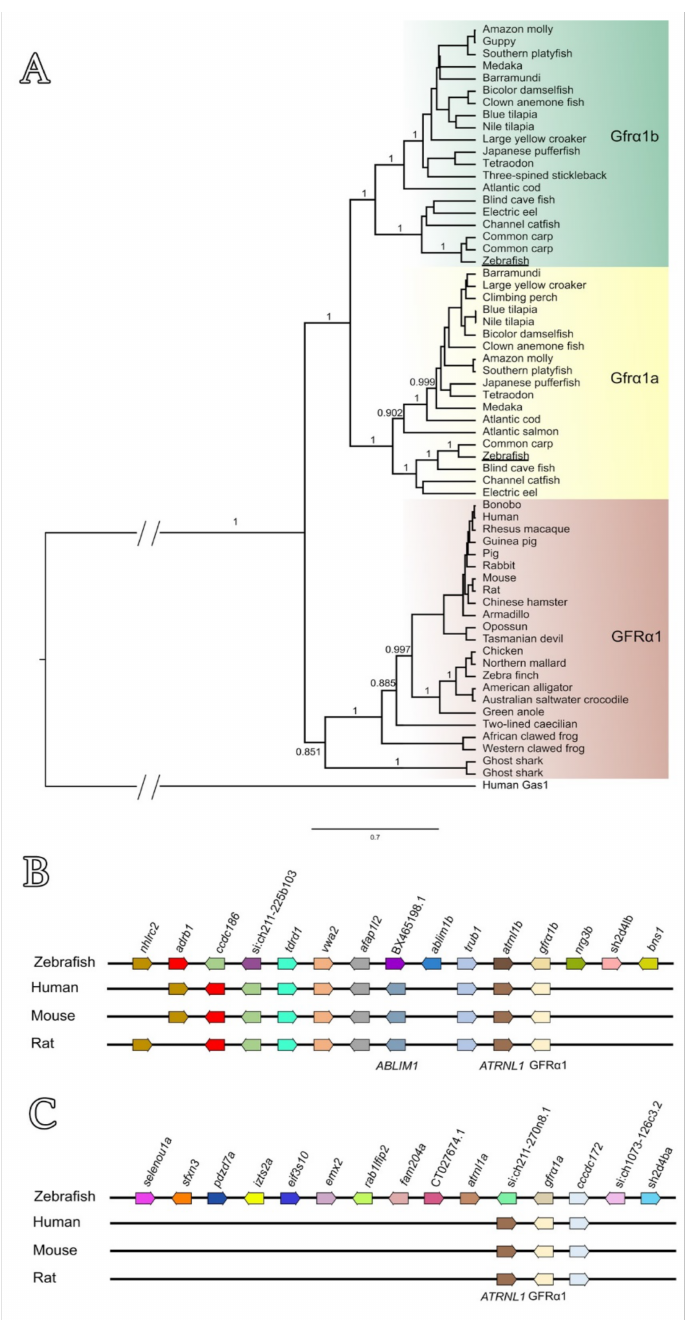
Figure 2. ( A ) Phylogenetic analysis of GFR α 1 predicted amino acid sequences across vertebrates. Zebrafish Gfr α 1a and 1b (both underlined) are clustered with other fish-specific Gfr α 1a (yellow box) and Gfr α 1b (green box) sequences, respectively, forming two separate subclades. Note that the GFRA1 sequences from other vertebrates (mammals, birds, reptiles, amphibians and Chondrichthyes) formed a separate clade (brown box). Branch values represent posterior probabilities obtained by Bayesian analysis (see Table S1). ( B , C ) Genomic organization and synteny comparisons among human GFRA1 , rodents Gfr α 1 and zebrafish gfr α 1b ( B ) or zebrafish gfr α 1a ( C ). The syntenic regions were analyzed according to the alignment of the target genes and genomic annotation available in the GenBank database (National Center for Biotechnology Information and